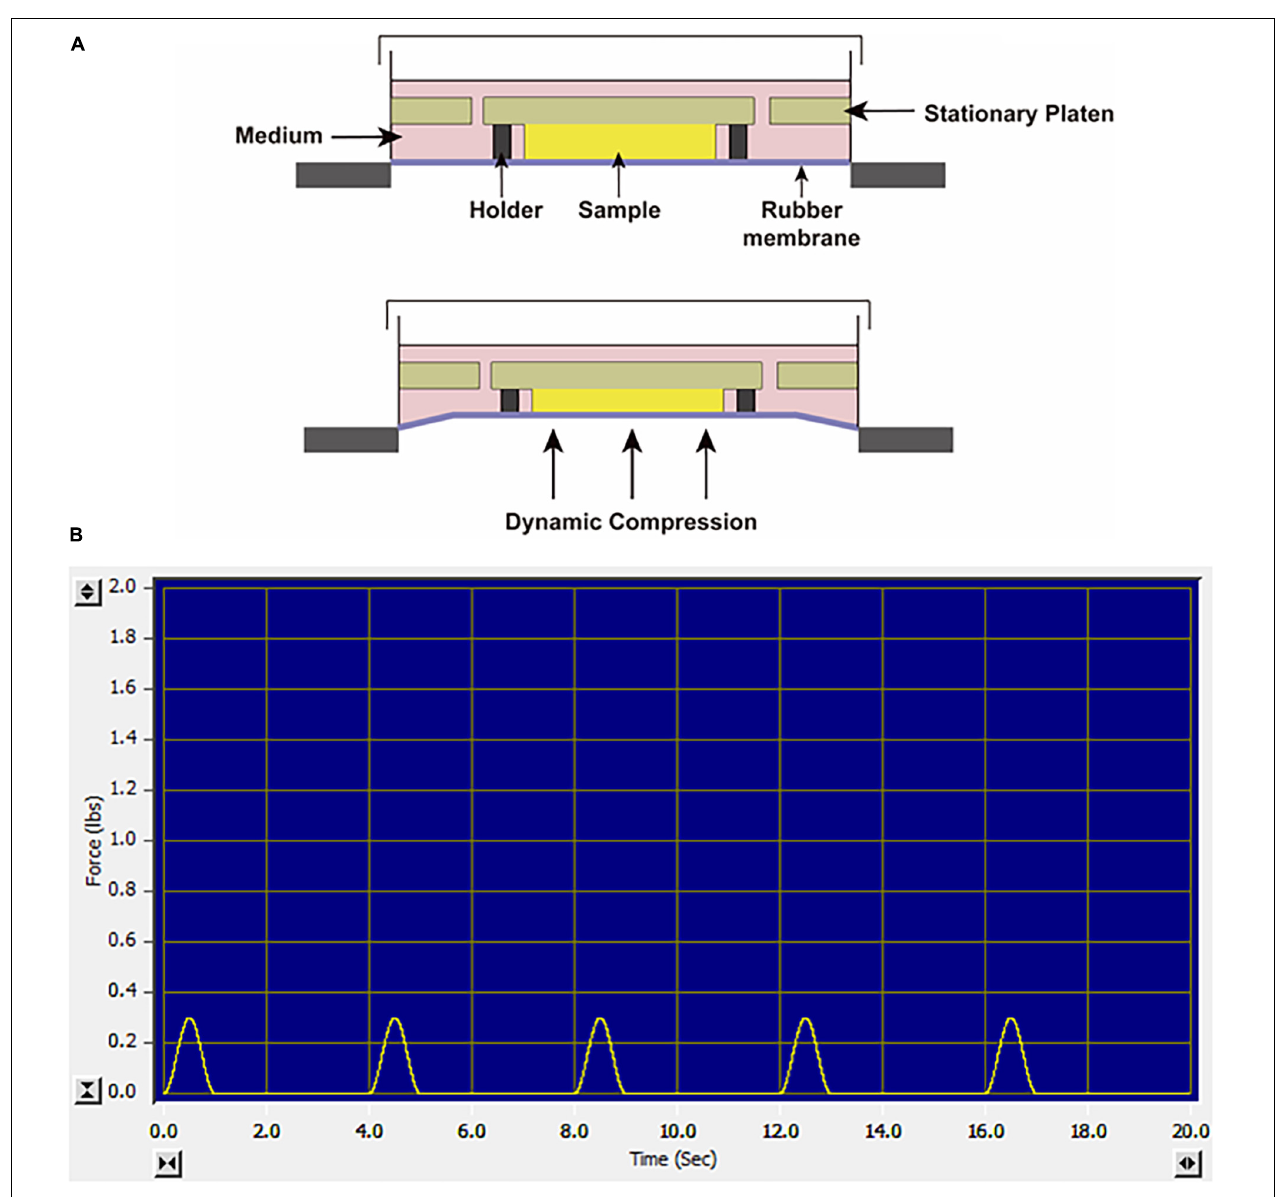
FIGURE 1 | (A) Schematic diagram of the FX-5000TM Compression System. (B) The screenshot of the monitor system when the constructs were exposed to sinusoidal dynamic compression at 10 kPa, 0.25